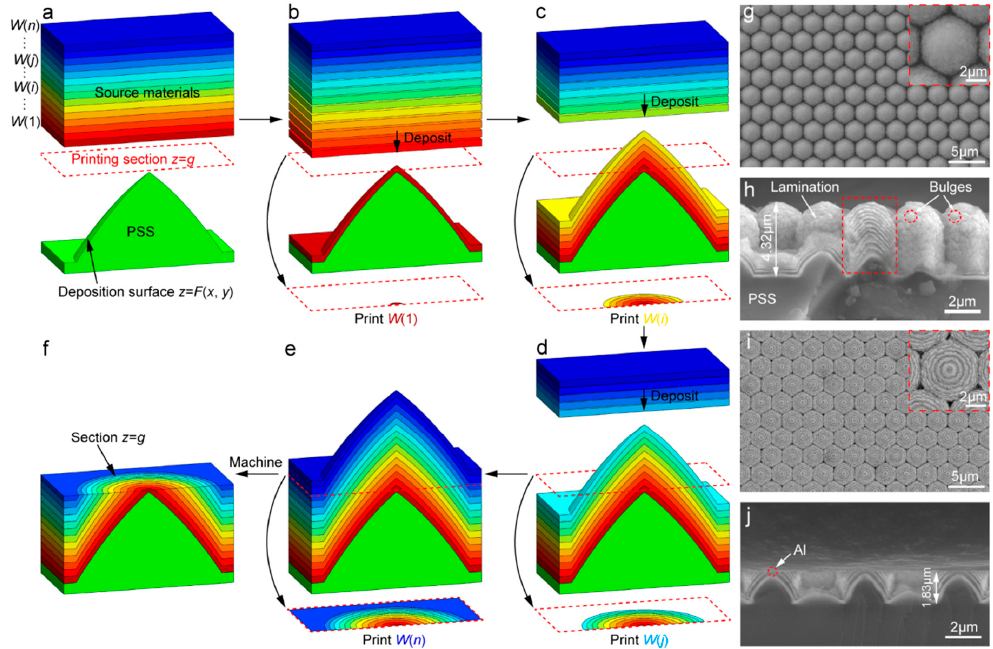
Figure 3. Morphology-Guided Printing (MGP) of multiple materials on printing section z = g